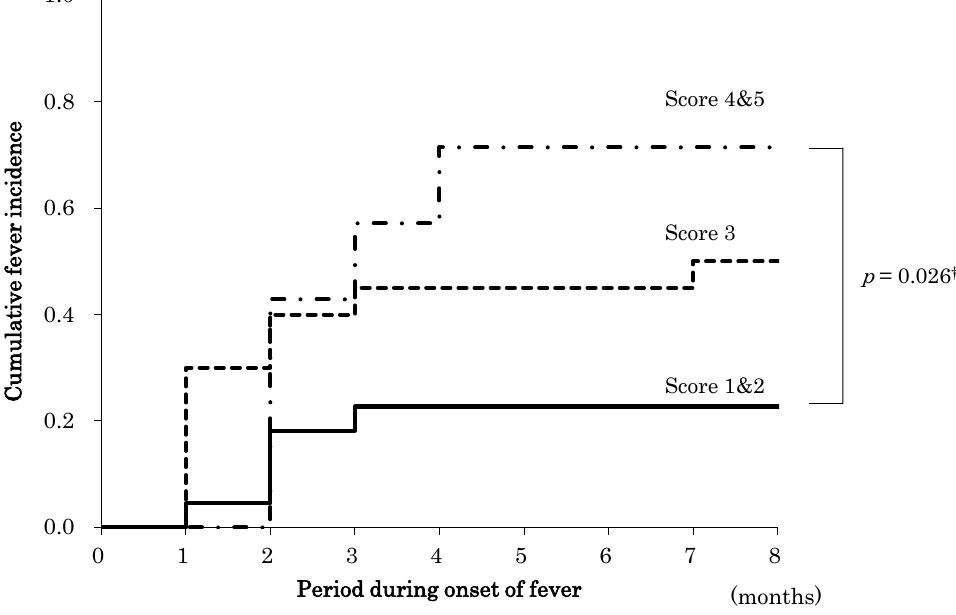
Figure 2. Incidence curves according to ADCHECK ® scores. The x-axis shows the follow-up duration (months). † = log-rank test.